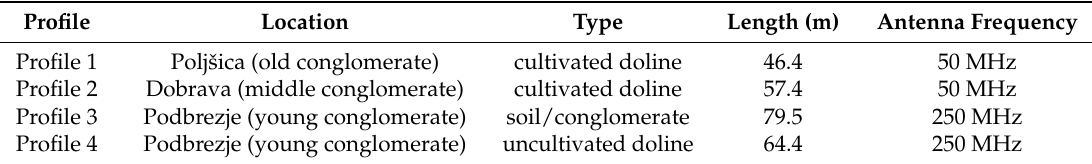
Table 3. Basic data of the presented GPR profiles acquired with the 50 MHz unshielded and 250 MHz shielded